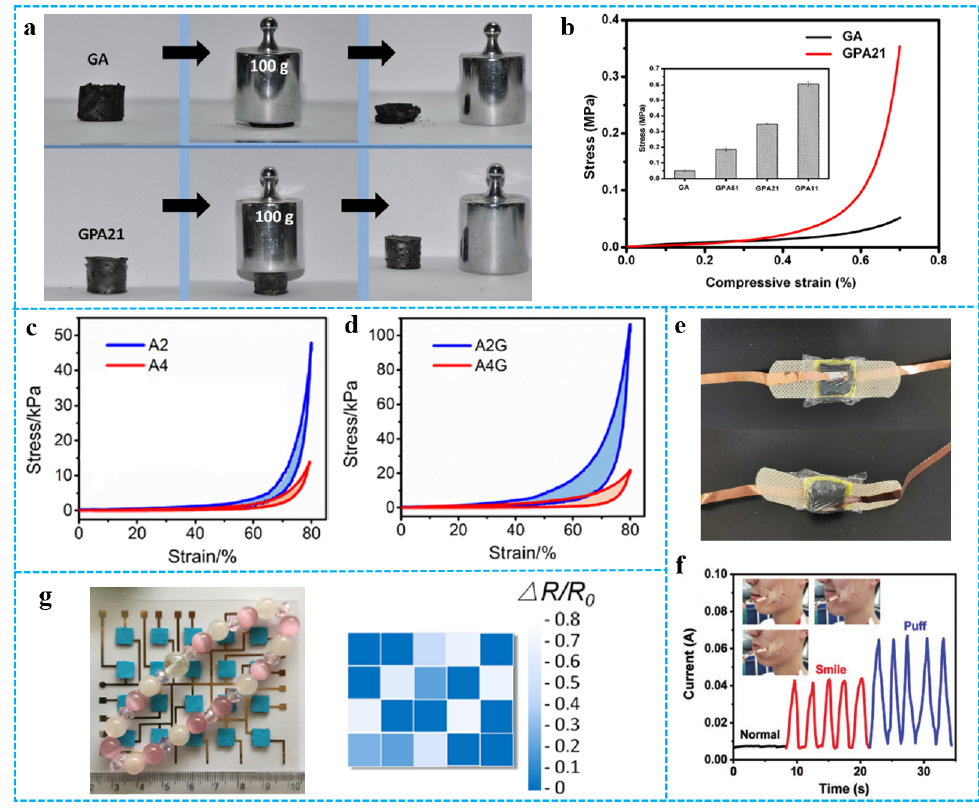
Figure 11. ( a ) Digital images showing compressibility of pure GA and GPA21. ( b ) The compressive stress − strain curves of GA and GPA21 at the maximum strain of 70%, inset is the average compres- sive strength of GA and GPAs. Reproduced with permission from [24]. ( c,d ) Stress − strain curves of compression − decompression tests on A2/A4 and A2G/A4G. Reproduced with permission from [99]. ( e ) Digital photo of the assembled CNF/CNT/RGO carbon aerogels sensor. ( f ) Current signals from facial expressions (normal, smile, and puff). Reproduced with permission from [106]. ( g ) Bracelets on flat PDMS/graphene aerogel sensor arrays and the signal output. Reproduced with permission from [99].